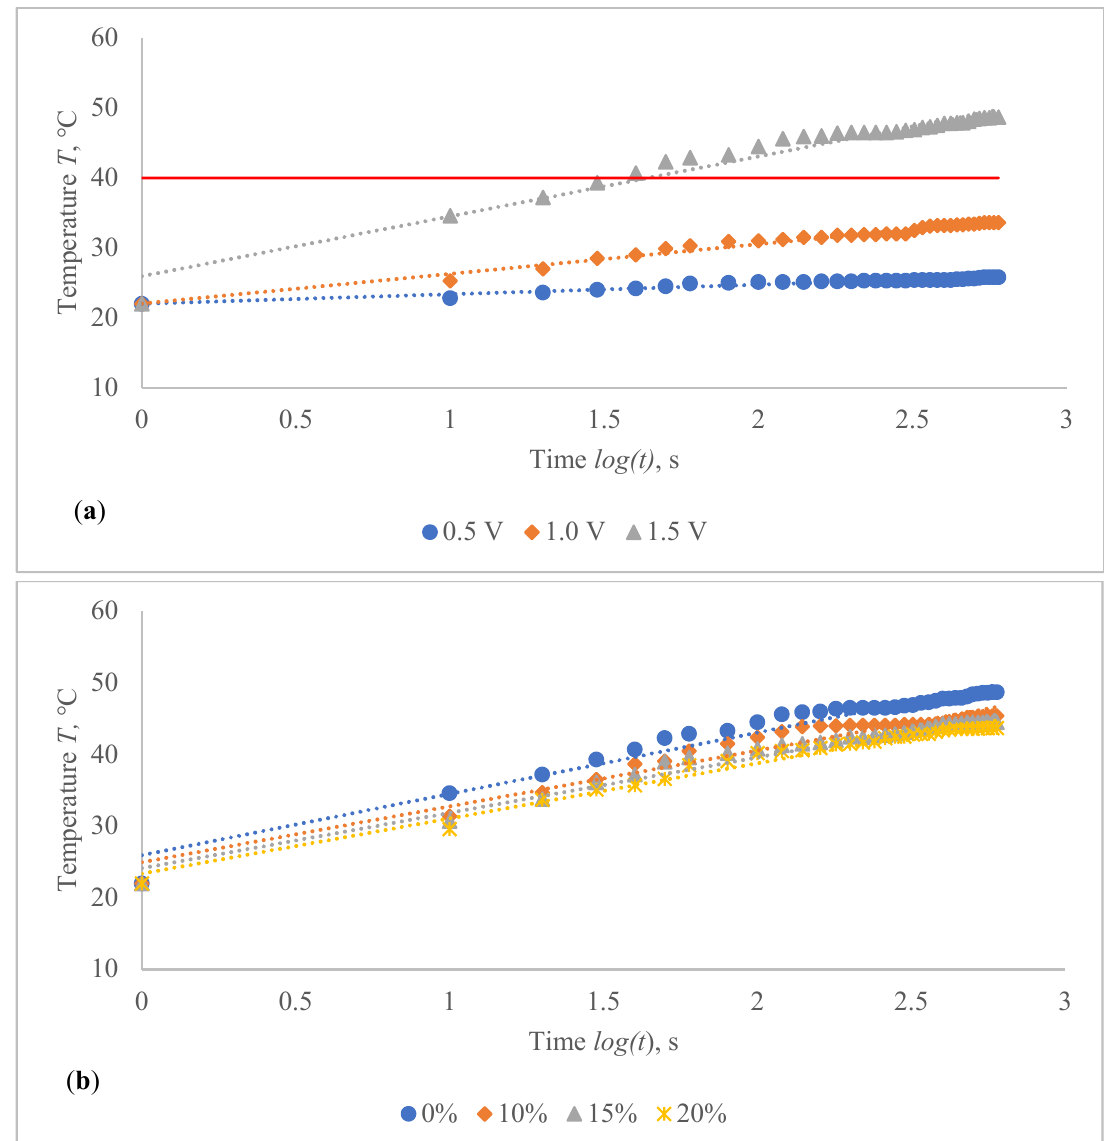
Figure 15. Temperature changes of CF_HY3 structured electro-conductive composite fabric during the 600 s period: ( a ) at non-stretched state by applying different voltage; and ( b ) at the different stretch levels by applying 1.5 V. Red line indicates the target